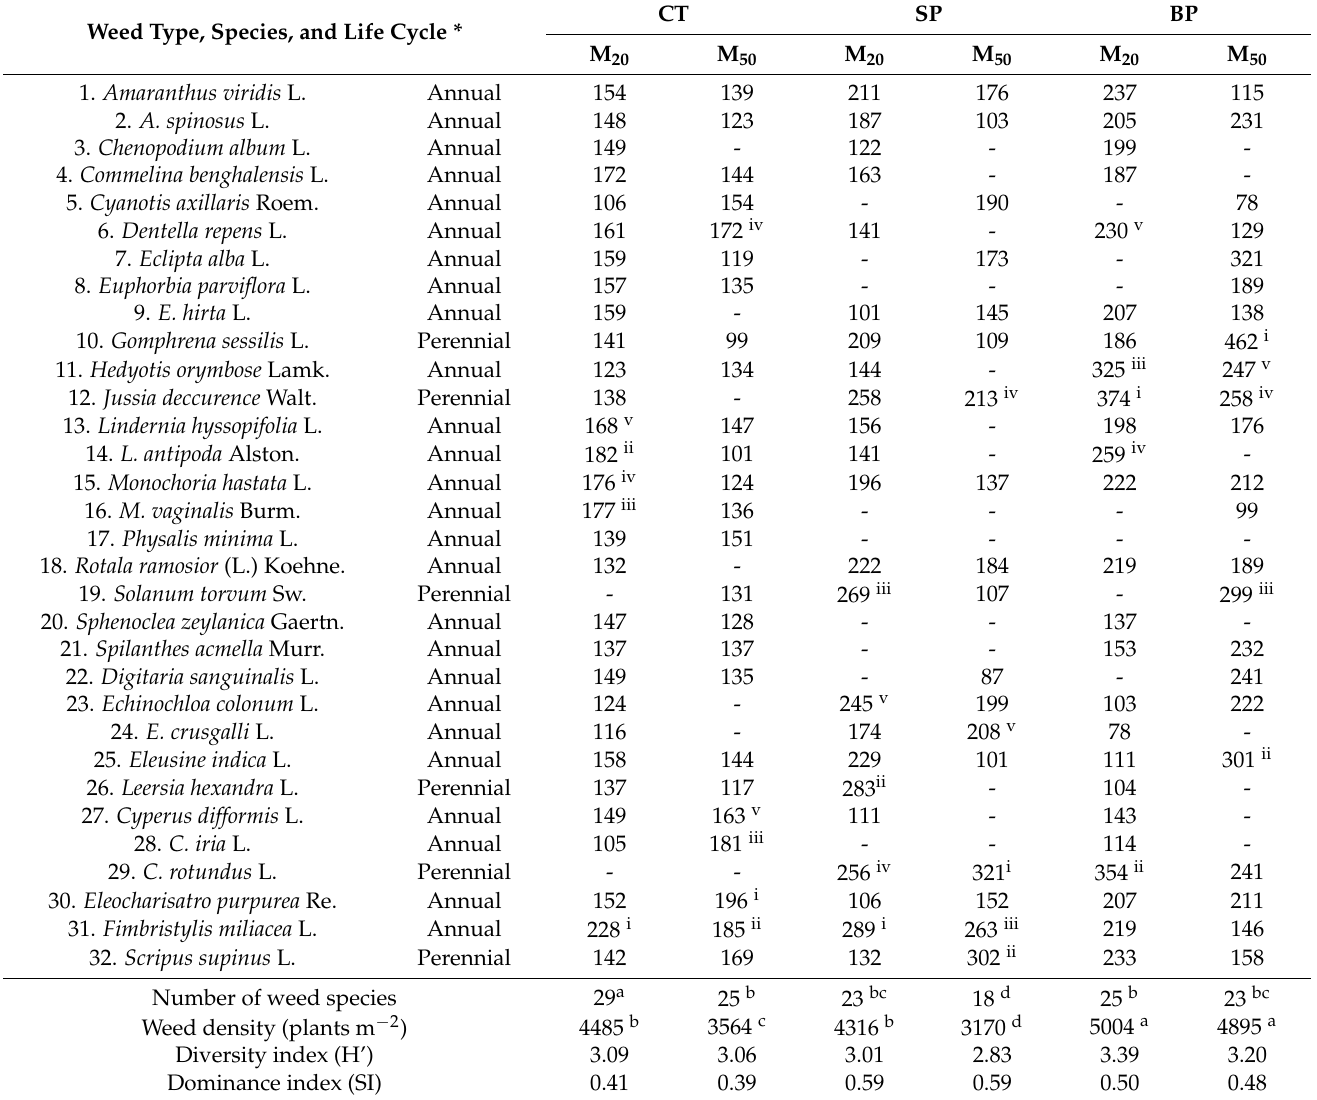
Table 2. Seedbank composition and weed density (plants m –2 ) as affected by tillage and residue mulch treatments in Digram after 5